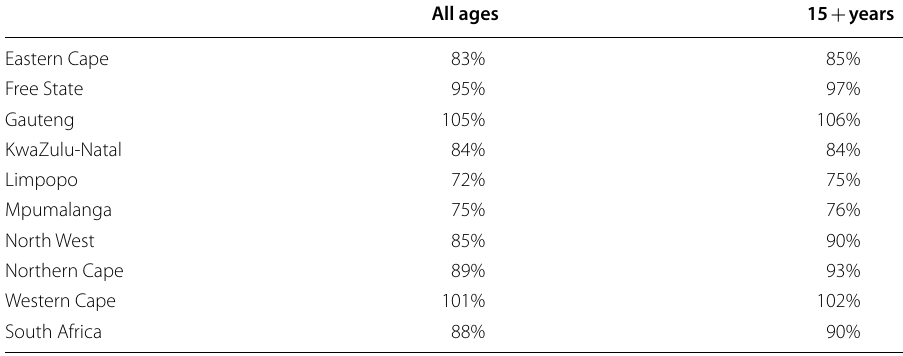
Table 2 Estimates of completeness of deaths by